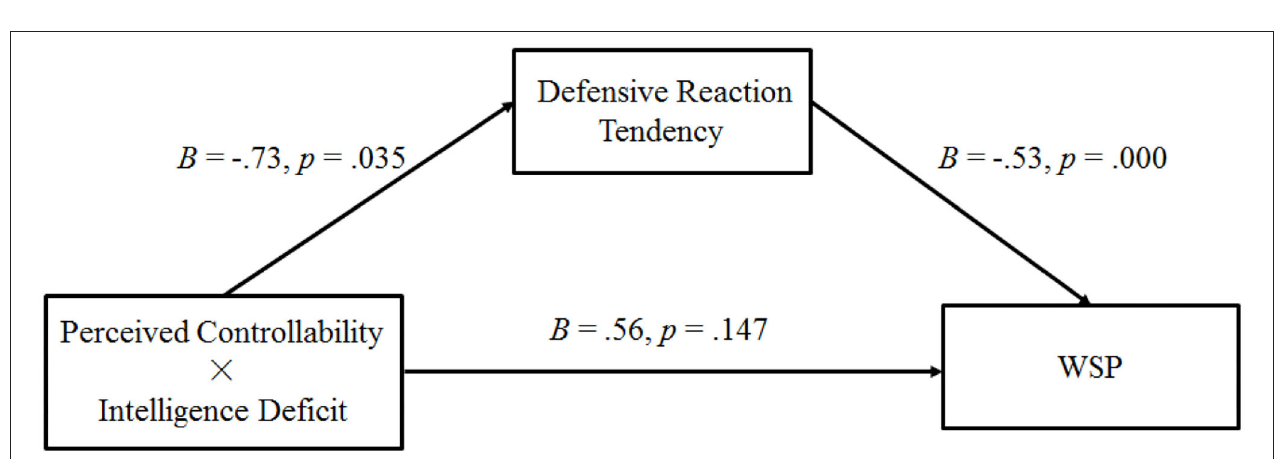
FIGURE 3 | Results of Experiment 1: path analysis of Experiment 1 (WSP, willingness to purchase self-improvement